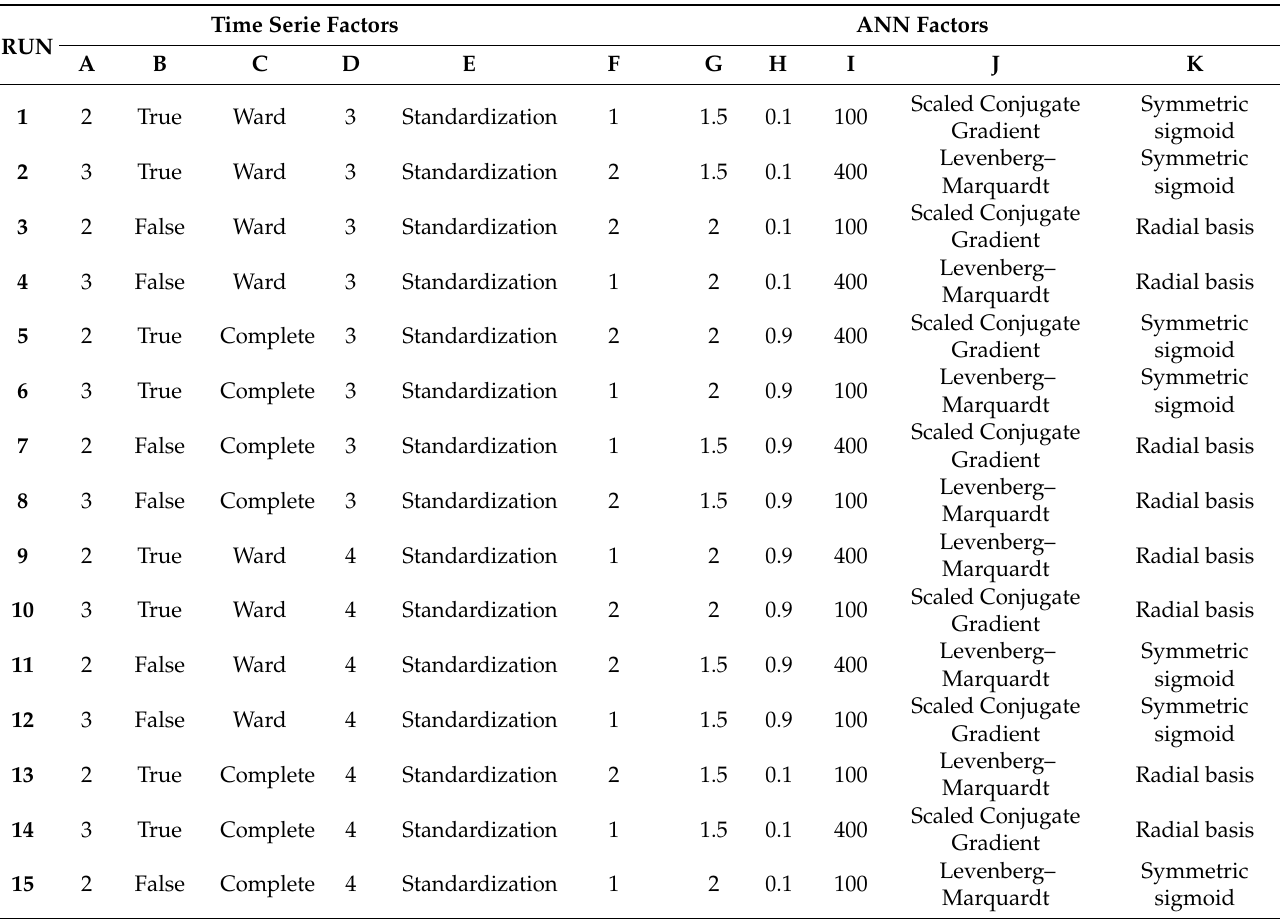
Table 4. Structure of the DOE experimental